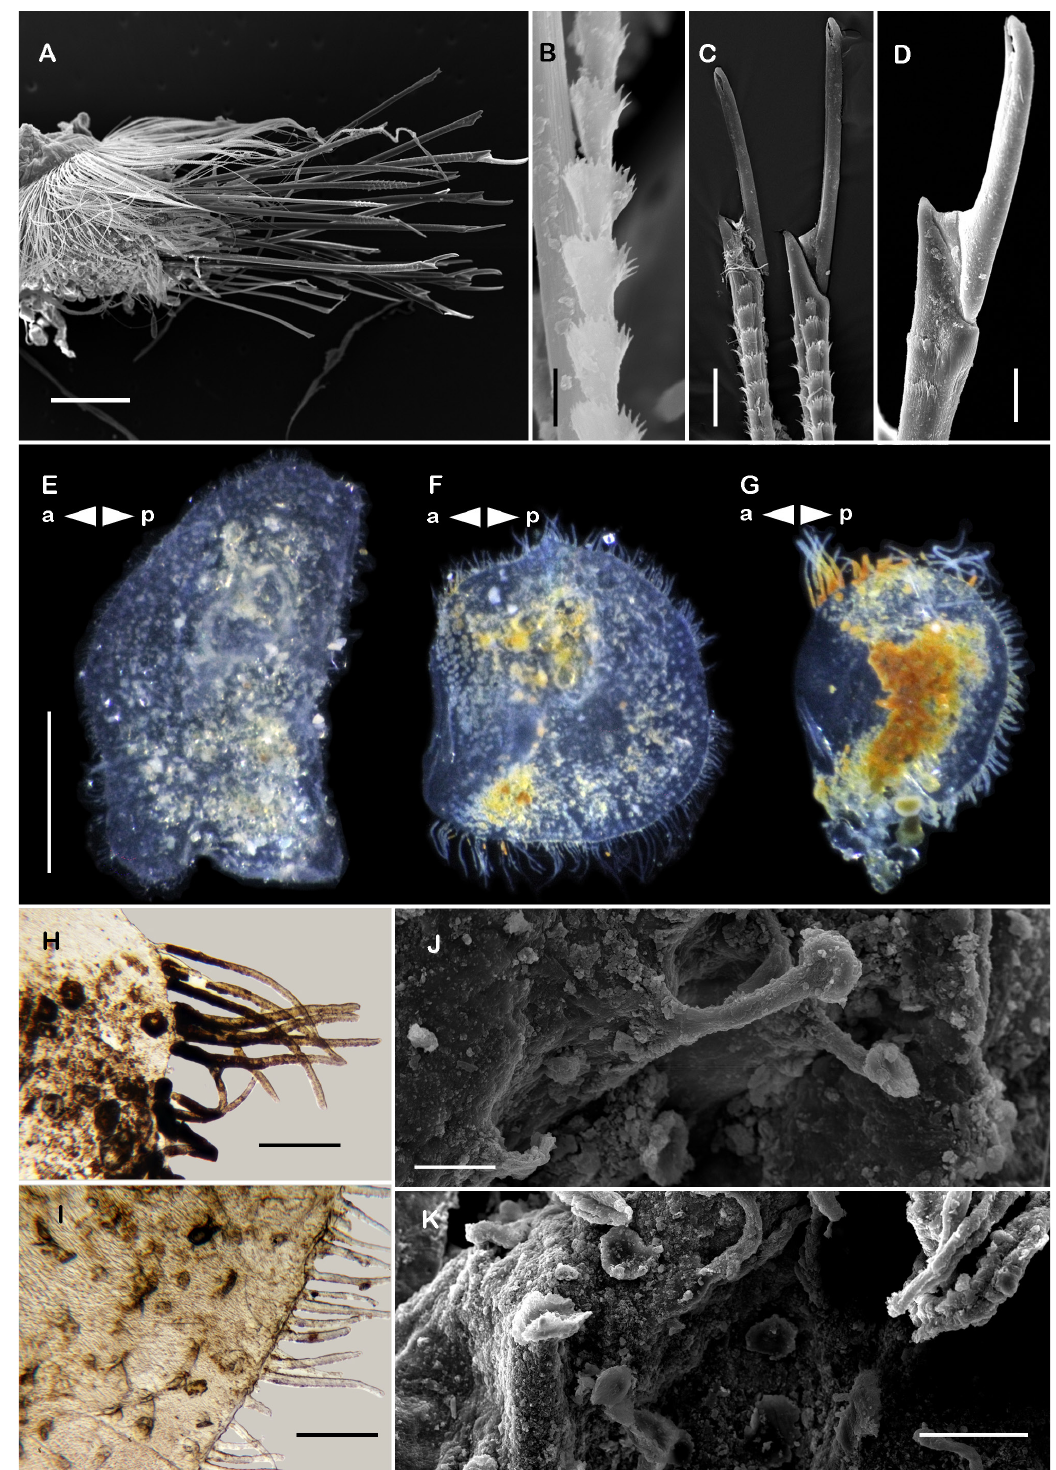
Fig. 8. Neopsammolyce floccifera (Augener, 1906), non-type material (UMML 6806-727). A–D, J–K. SEM micrographs A . Right parapodium from segment 26. B . Notochaetae from same. C . Unit A. D . Unit B. E . First right elytron. F–G . Posterior elytra. H . Long dendritic papillae. I . Short dendritic papillae. J . Pedunculate papillae with flat tips. K . Flat papillae. Abbreviations: a = anterior; p = posterior. Scale bars: A = 200 μm; B = 2 μm; C–D, H–J = 20 μm; E–G = 1 mm; K = 50